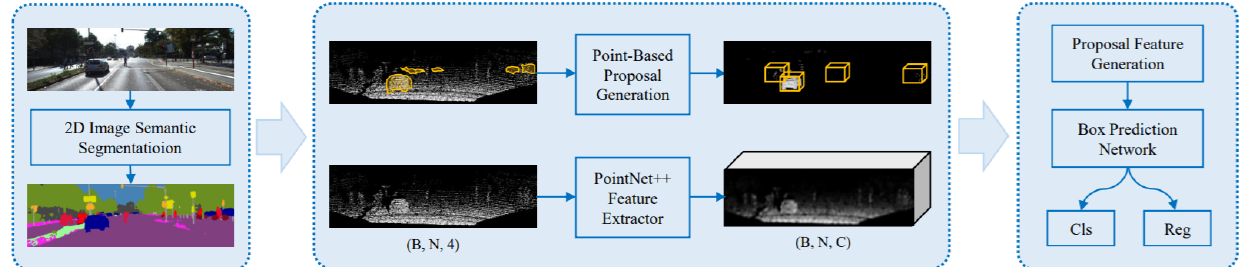
Figure 15. Illustration of IPOD [66] consisting of a sub-sampling network, point-based proposal generation, and the components of network architecture, which classifies and regresses the generated proposals.